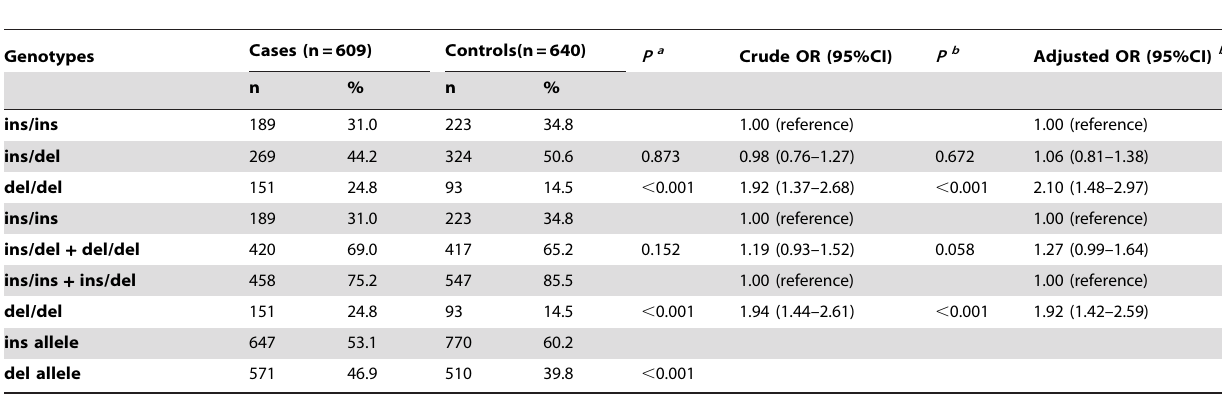
Table 2. Genotype and allele frequencies of the NFKB1 promoter -94 ins/del ATTG polymorphism among the bladder cancer cases and controls.